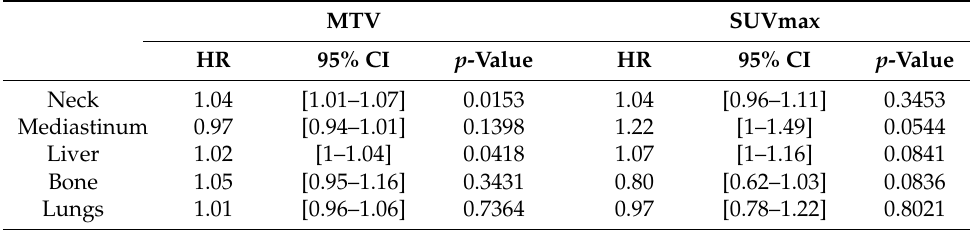
Table 7. Multivariate Cox analysis of 1-year OS. HR: hazard ratio.